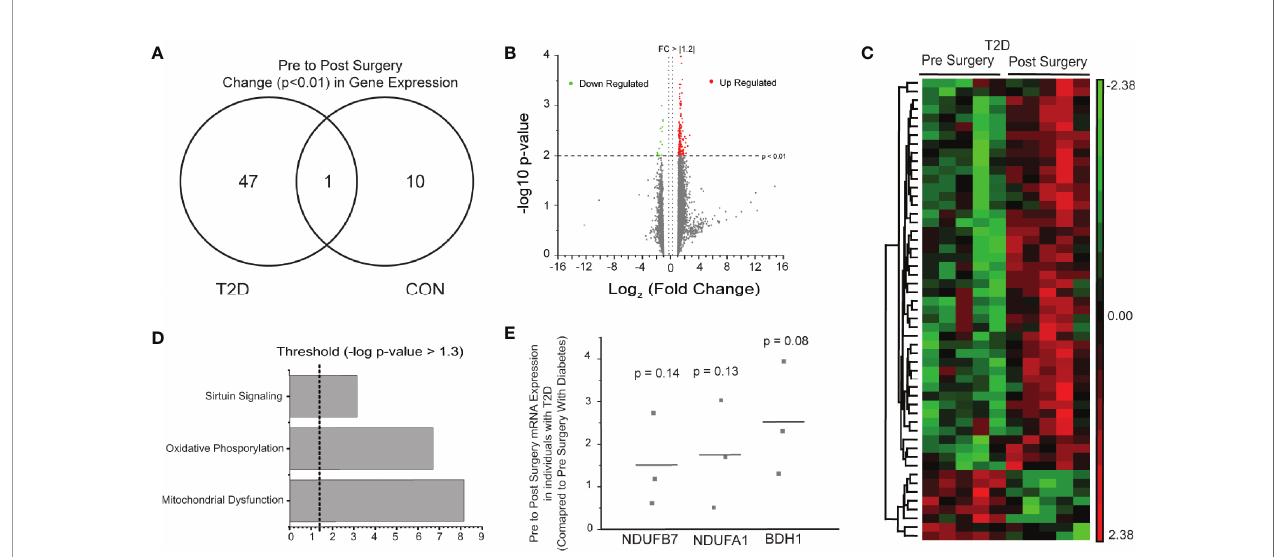
FIGURE 2 | Pre to post-surgery skeletal musclegene expression. (A) Venn diagram of signi fi cant probes inindividualswith diabetes andwithout diabetes, and overlap, pre- to-post surgery. (B) Volcano plot of 25,839 probes used for statistical analysis. Green (Down Regulated) and Red(Upregulated)of 53 signi fi cant ( p < 0.01, FC> |1.2|) probes for Pre-to-Post surgerygene expression in T2D skeletal muscle. (C) Heat map(probeintensities)of48 signi fi cant ( p < 0.01, FC> |1.2|) probes pre-to-post surgery in individuals with diabetes. (D) Signi fi cant pathwaysfrom Ingenuity Pathway Analysis using the Canonical Pathway tool.Presented pathways are overrepresented with genes